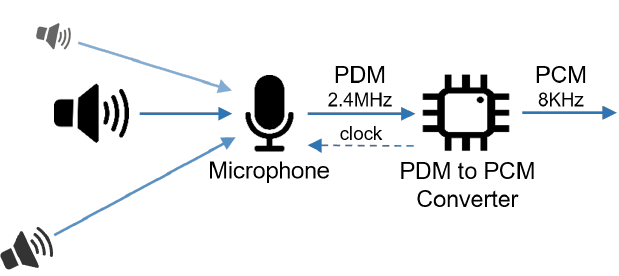
Figure 4. Data acquisition system with the PDM to PCM converter.